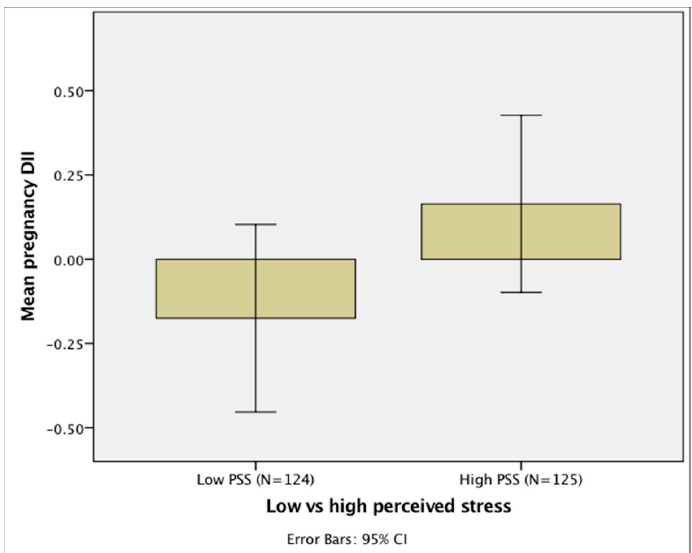
Figure 3. Bar chart depicting the association of prenatal DII score with maternal PSS. CI: Confidence